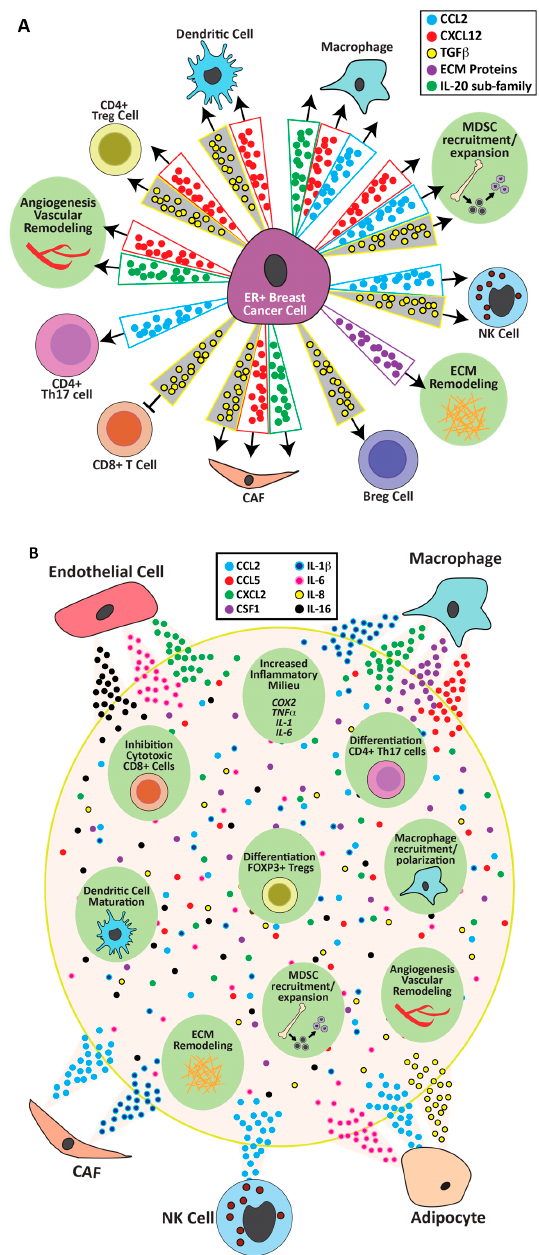
Figure 2. Changes in estrogen potentially can tilt the balance of immune activity by acting directly on multiple cell populations in the ER+ breast cancer environment to modulate the cytokine/chemokine milieu and extracellular matrix (predicted by experimental studies discussed in Section 5). ( A ) Es- trogens and anti-estrogens acting on ER+ breast cancer cells impact major communication arcs in the TME. Arrows indicate increased numbers and/or function; blocks indicate inhibition. Agonists increase expression of the molecules shown in the legend, represented by white triangles. Antago- nists increase TGF β , as shown in the shaded triangles. ( B ) Estrogen increases chemokine/cytokine secretion from stromal cell populations (outer ring), which would alter multiple immune processes in the ER+ TME (center). Importantly, these predictions are based on studies in defined model systems, which need significant additional study in the context of diverse primary and metastatic ER+ breast cancers. Moreover, as discussed in the text, estrogen signals can be modified by the cytokine milieu, and the ability of target cells to respond varies with differentiation state and other local environmental cues, which evolve with tumor